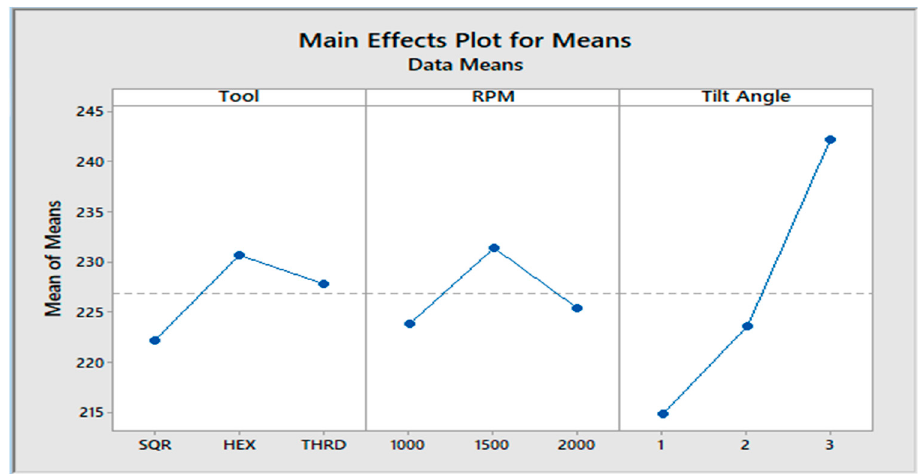
Figure 9. Main effects between the mean of means and process parameters.